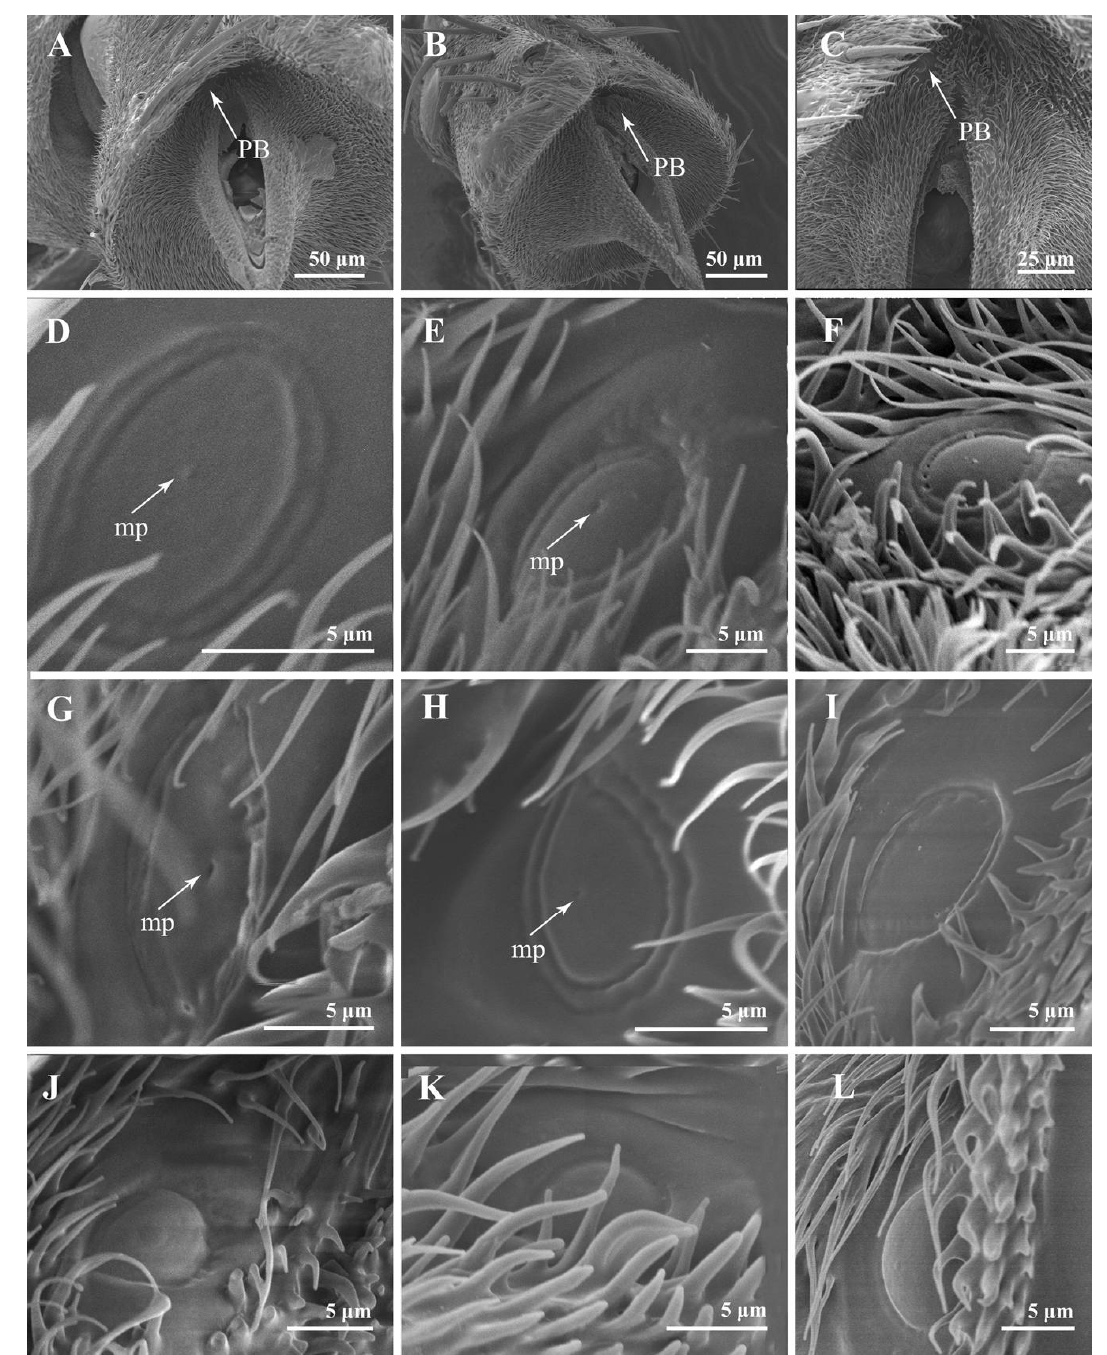
Figure 2. The setiferous plaques on the antennal pedicel of male S . albiceps , S . africa , S . peregrina , W . magnifica , and A . mihalyii . ( A , B ) S . albiceps , ( C , D ) S . 6frica , ( E , F ) S . peregrina , ( G , H ) W . magnifica , and ( I , J ) A . mihalyii . Abbreviations: mp (micropore); Pl (setiferous plaque).